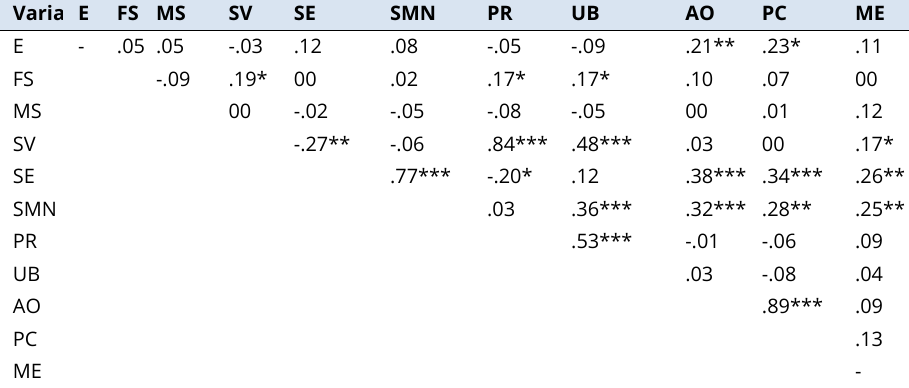
Correlation among Demographic Variables and Charismatic leadership, Mentoring Effectiveness and Self-Determination in Teachers (N=150)